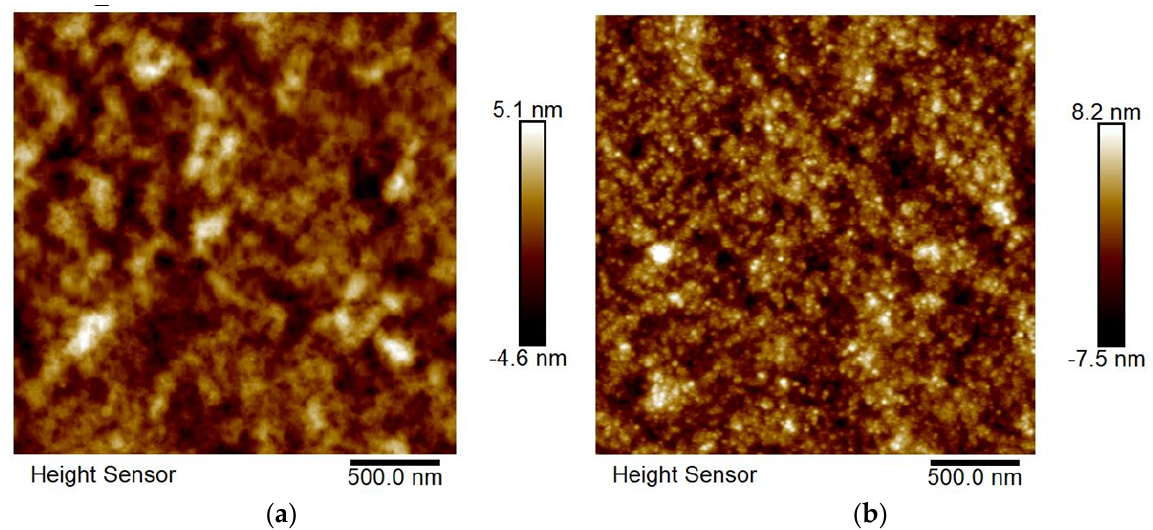
Figure 7. AFM tapping mode height images of: ( a ) P3HT:PCBM active film and ( b ) ZnO interface layer of flexible polymer–organic solar cells.